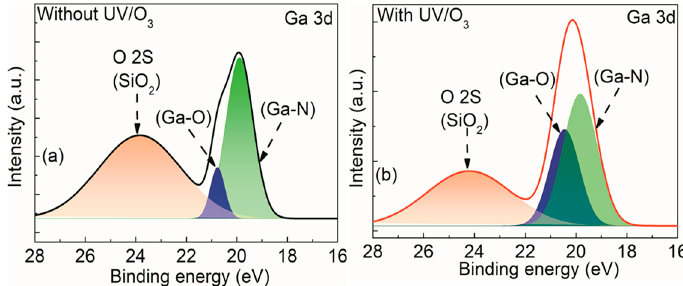
Figure 2. X-ray photoelectron spectroscopy (XPS) measurements of Ga 3d core levels in ( a ) without UV/O 3 and ( b ) with UV/O 3 surface-treated GaN MOS-HEMT.